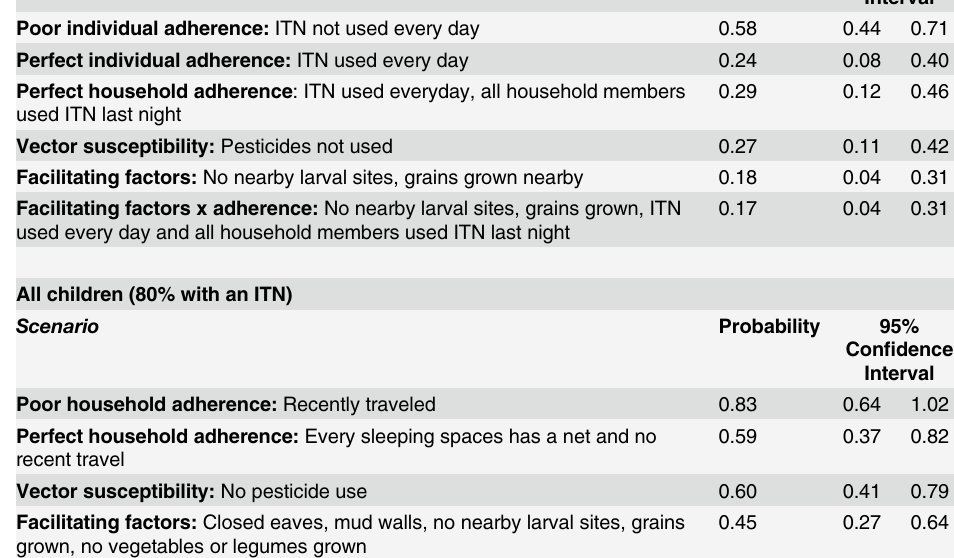
Table 6. Predictive margins. Probability of malaria for different values of specific covariates by domain. Each scenario holds all other model covariates at their mean value. Children with ITNs